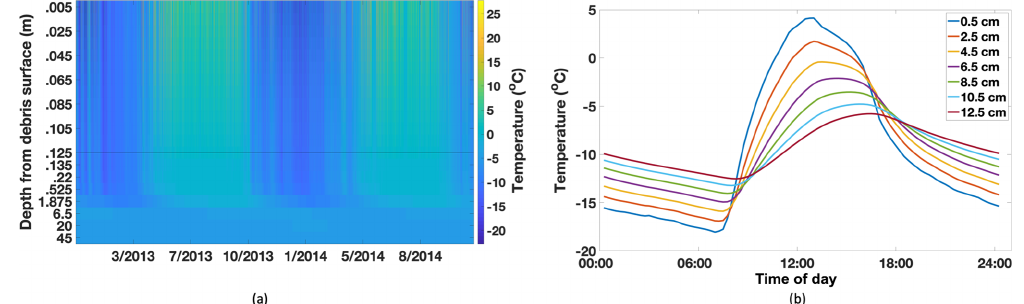
Figure 7. (a) Temperatures in the debris and underlying glacier throughout the period used for this study. The black line indicates the debris– ice interface. The depth scales for debris and ice differ; debris thickness is 0.125m whereas the ice extends to 60m (note the nonlinear y scale in the ice). Y labels correspond to the mid-layer depth of the 20 discrete layers used in ISBA-DEB. The temperatures simulated throughout the whole 60m column over the entire forcing period show phase lag and attenuation with depth, characteristics that are more clearly seen in (b) , which shows the temperature of various debris depths during an arbitrary day (20 February